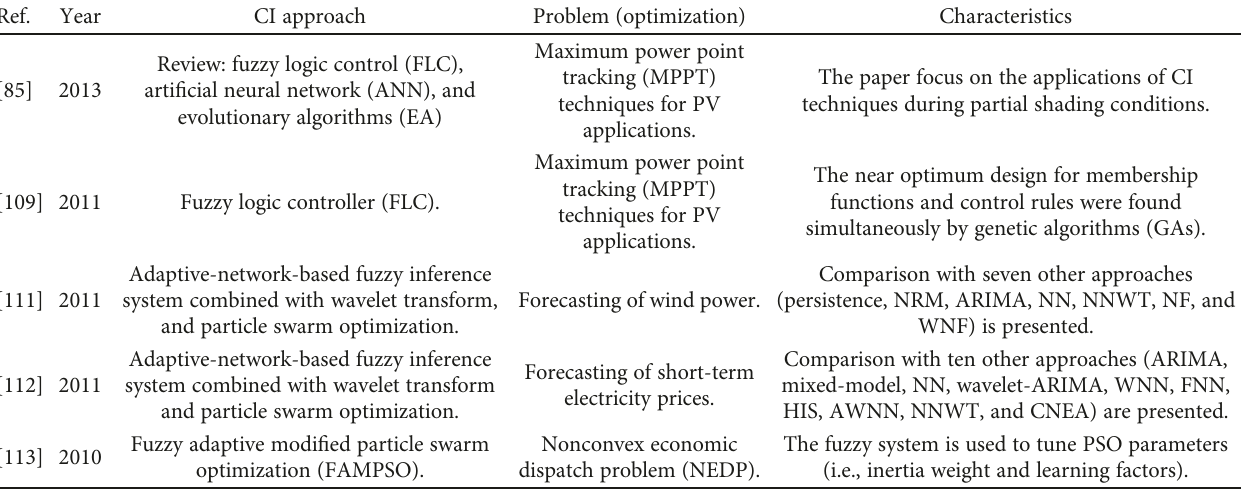
Table 6: Some selected highly cited papers of hybrid approaches applied to energy-related problems. Ref.